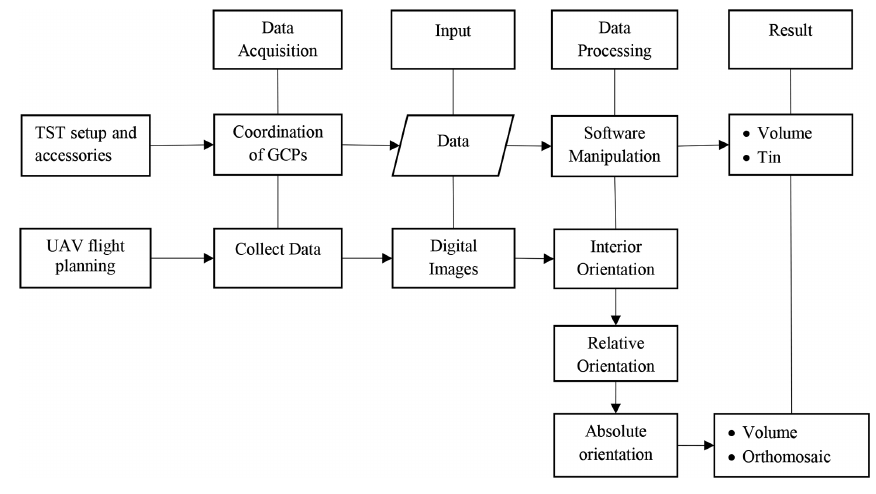
Fig. 2. A chart of the Table 1. Technical Parameters of DJI Mavic Air UAV.